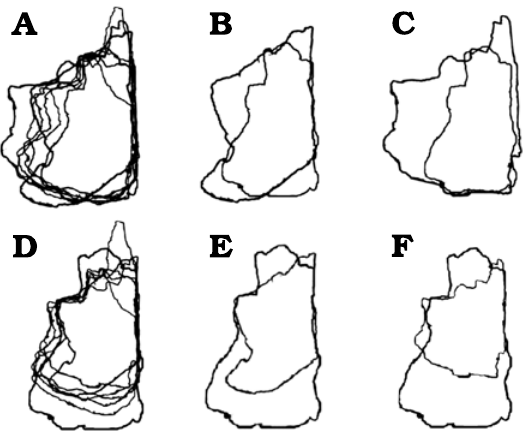
Fig. 6. Björk method of superimposition of the frontals in dorsal/ventral views. A . Scaled to same length between prefrontonasal process and the frontoparietal suture. B . Smallest and largest specimen superimposed. C . Smallest and second largest specimen superimposed. D . Scaled to same width between medial edge of the orbital slot and the midline. E . Smallest and largest specimen superimposed. F . Smallest and second largest speci- men superimposed. Largest specimens preserve entire nasal process, which emphasize relative shortening during growth. Not to scale.